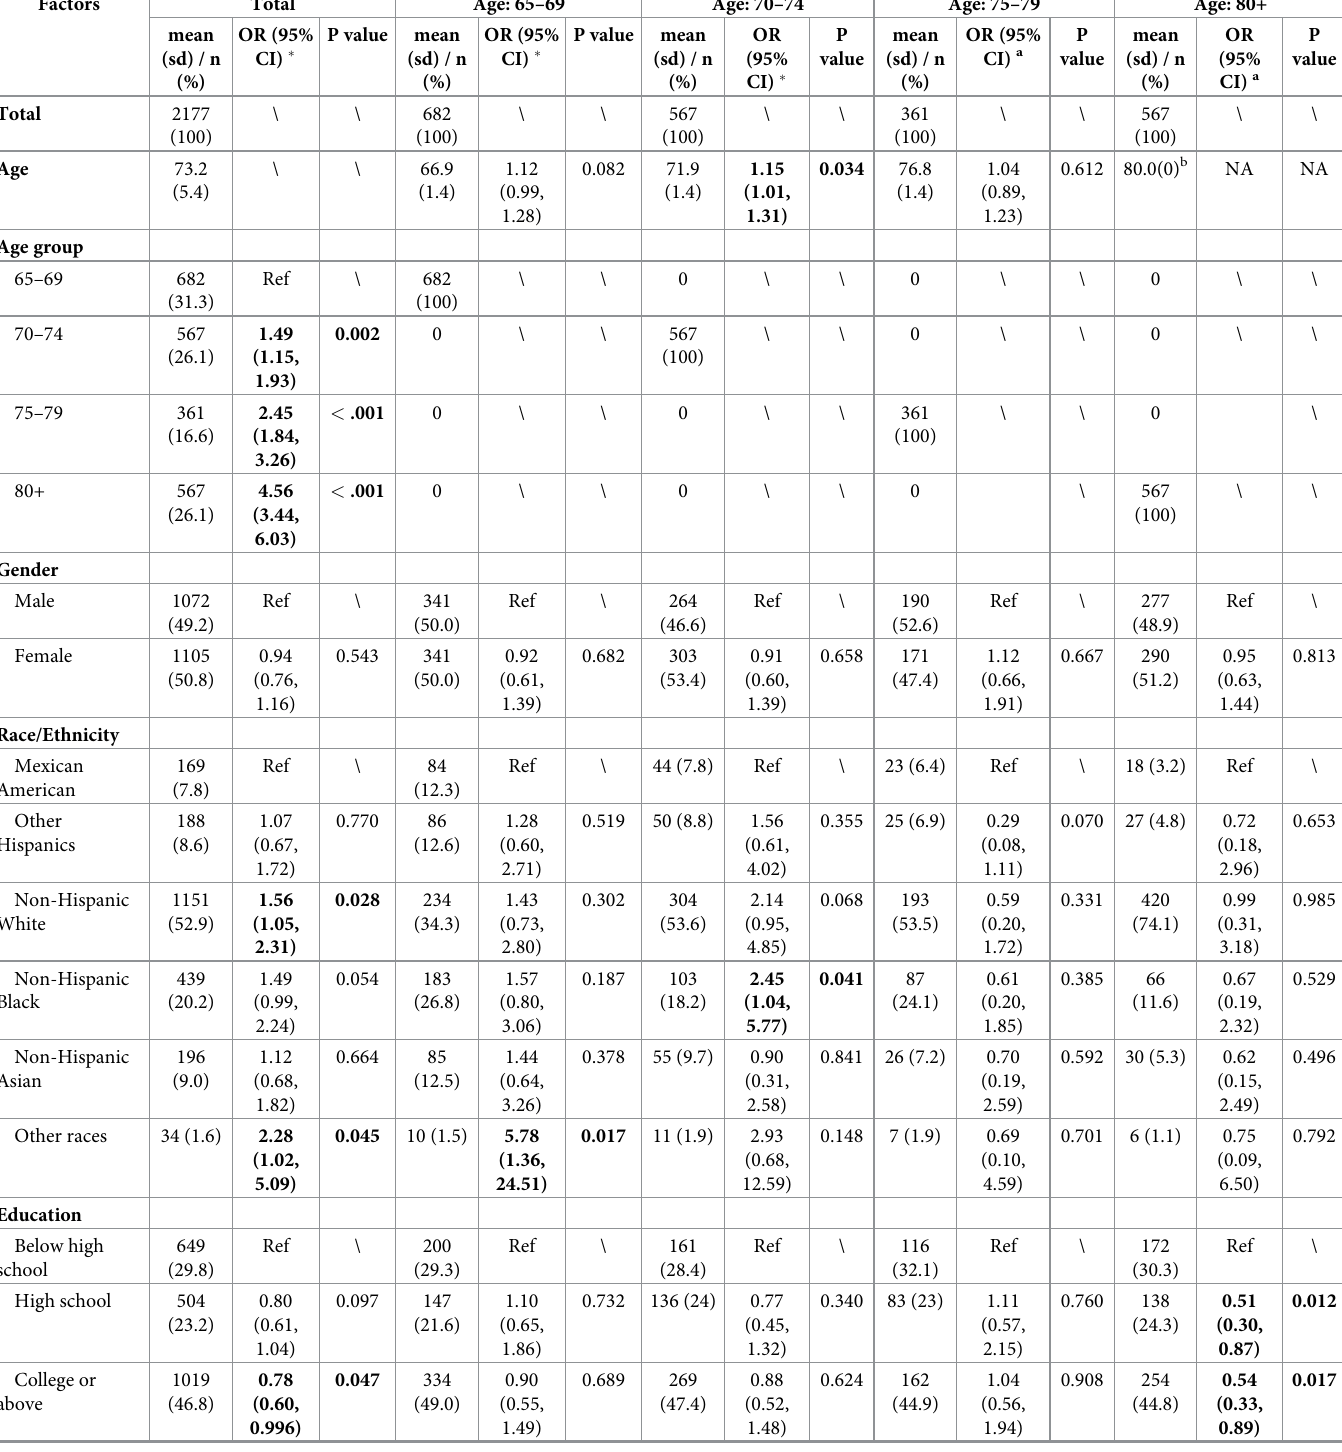
Table 4. Odds ratio (95% CI) of factors associated with CKD in US participants (NHANES 2011–2014).